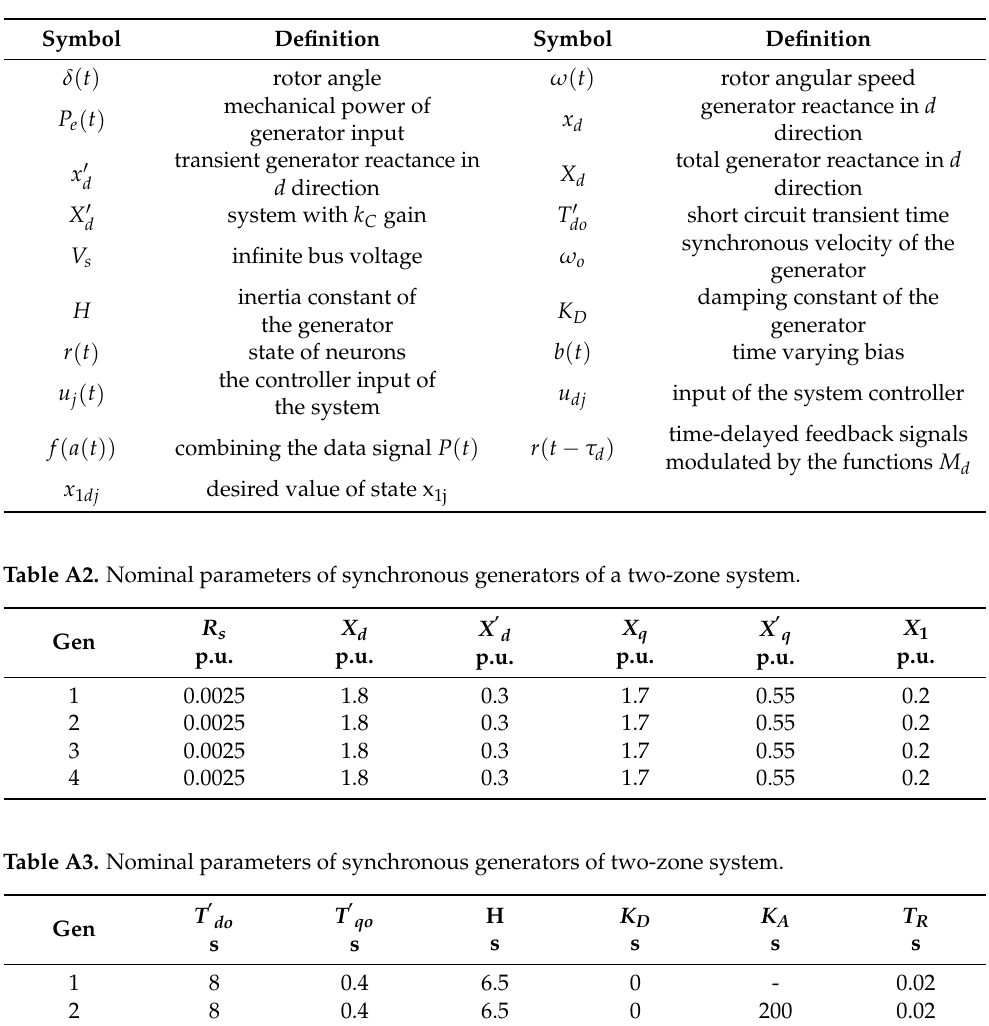
Table A1. Nomenclature.